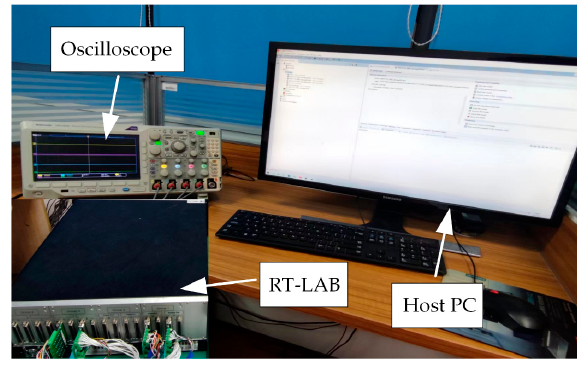
Figure 23. Experimental platform.